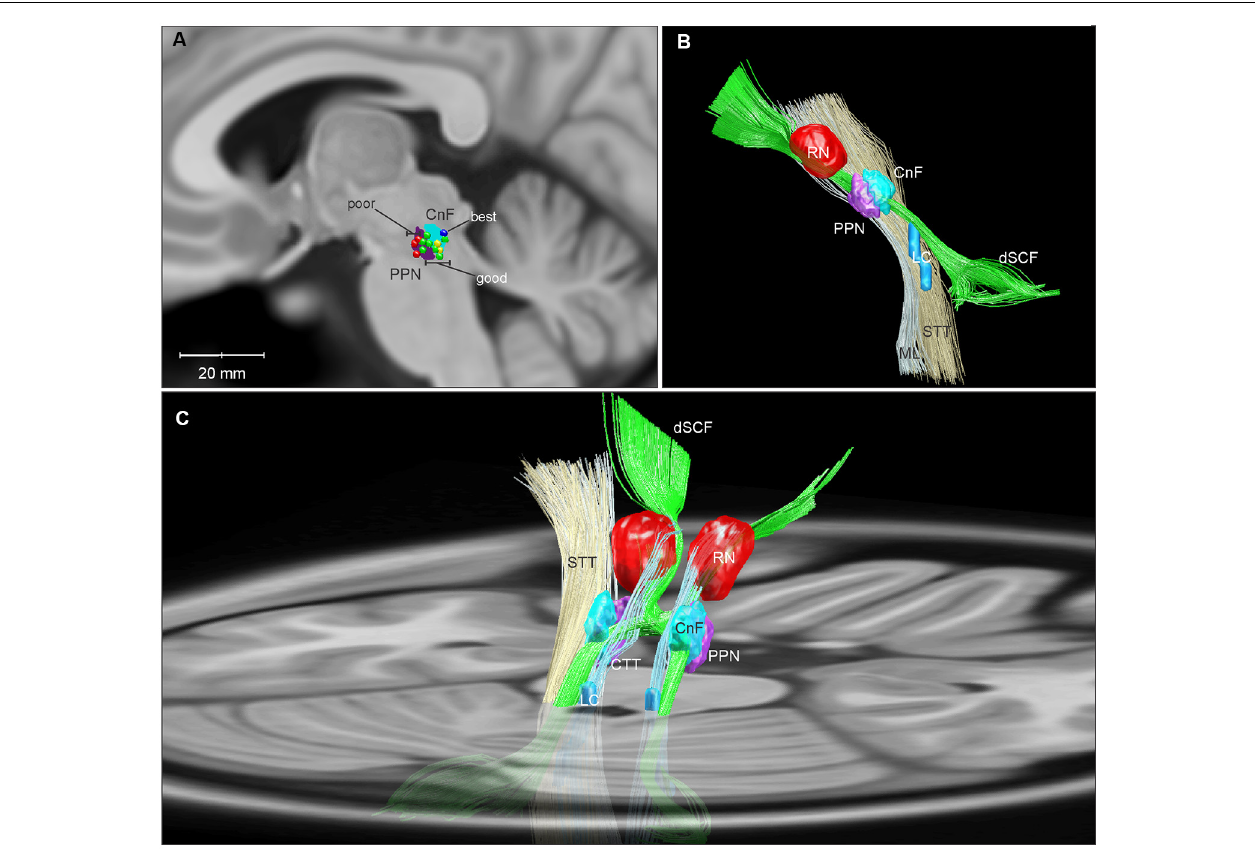
FIGURE 2 | Three-dimensional reconstructions of the human MLR and regional anatomy. Reconstructions were made using Lead-DBS and available MNI-space subcortical atlases (Horn and Kühn, 2015). A separate CnF NIfTI object (cyan) was created in MATLAB in relation to the PPN (purple) based on Olszewski and Baxter (1982). (A) A parasagittal projection (5 mm lateral to the midline) of the CnF and PPN is overlaid with active contacts from PPN DBS patients with poor (red), good (green), best (dark blue), and unevaluated (yellow) FOG outcomes from Goetz et al. (2019). (B) Sideview of 3D reconstruction of MLR and regional anatomy, with left ML and STT removed to show the CnF and PPN. (C) Diagonal view with right ML and STT removed, projected on to a transverse slice of the brain at the level of the pons. Abbreviations: CnF, cuneiform nucleus; CTT, central tegmental tract; dSCF, decussating superior cerebellar fibers; LC, locus coeruleus; ML, medial lemniscus; PPN, pedunculopontine nucleus; RN, red nucleus; STT, spinothalamic